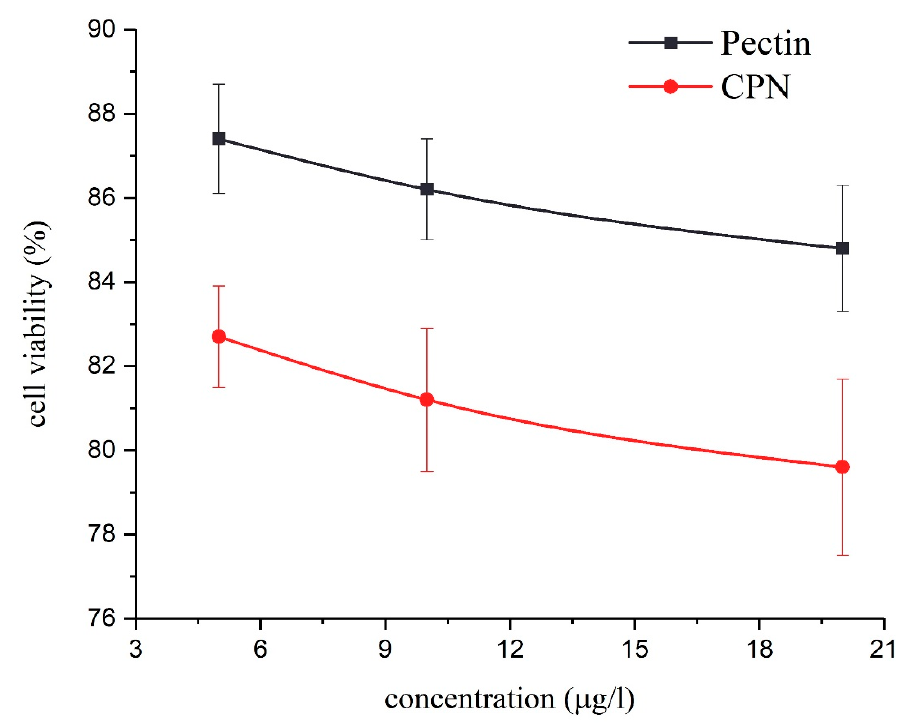
Figure 11. Comparative analysis of the percentage of cell viability against pectin and CPN. Figure 10. Comparative analysis of percentage cell viability against pectin and CPN 279